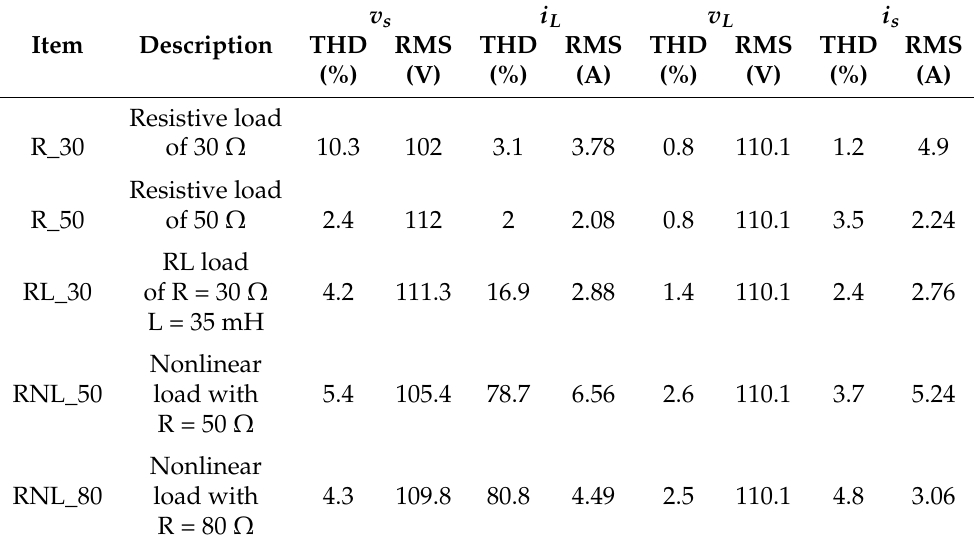
Figure 8. Results from a power analyzer and oscilloscope for the RNL_50 experiment of harmon- ics compensation. Table 2. Results of harmonics